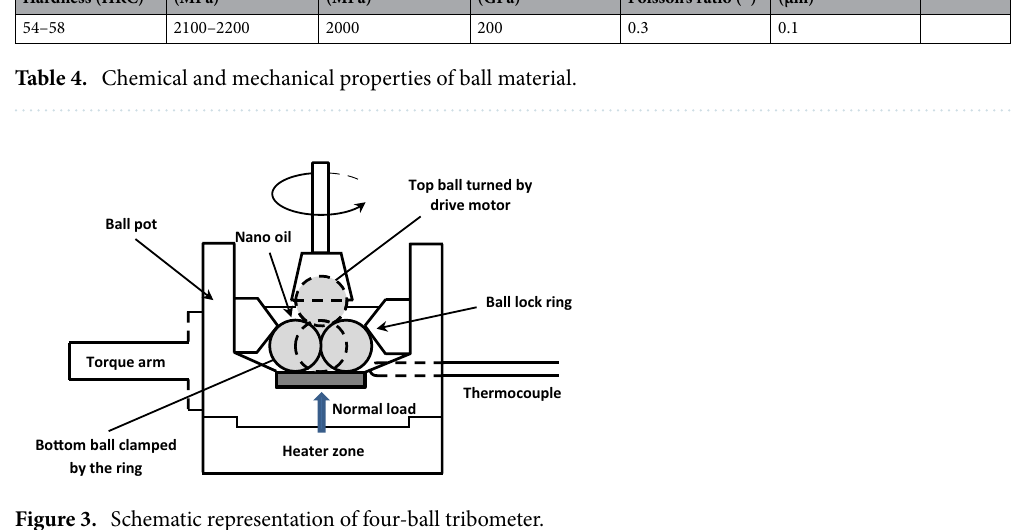
Figure 3. Schematic representation of four-ball